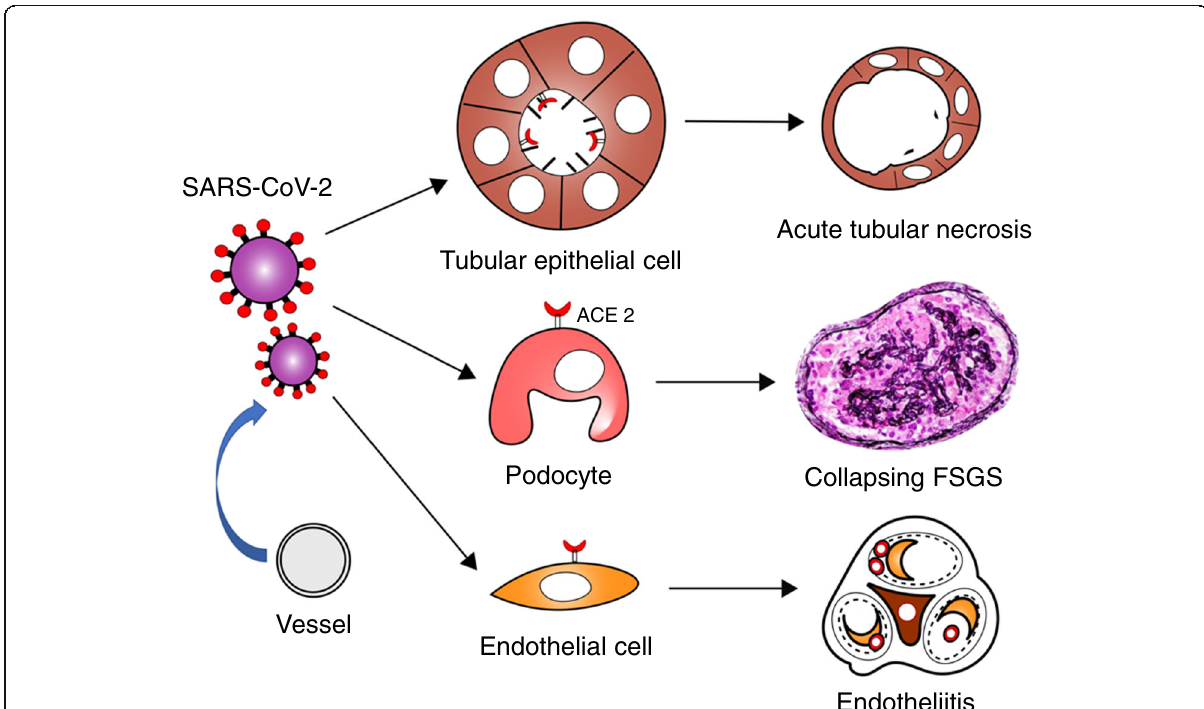
Fig. 1 Schematic of histological features of renal complications in COVID-19. SARS-CoV-2 infects several kidney host cells using ACE2 and causes various types of damage. Each damage can cause AKI. Abbreviation: FSGS, Focal segmental